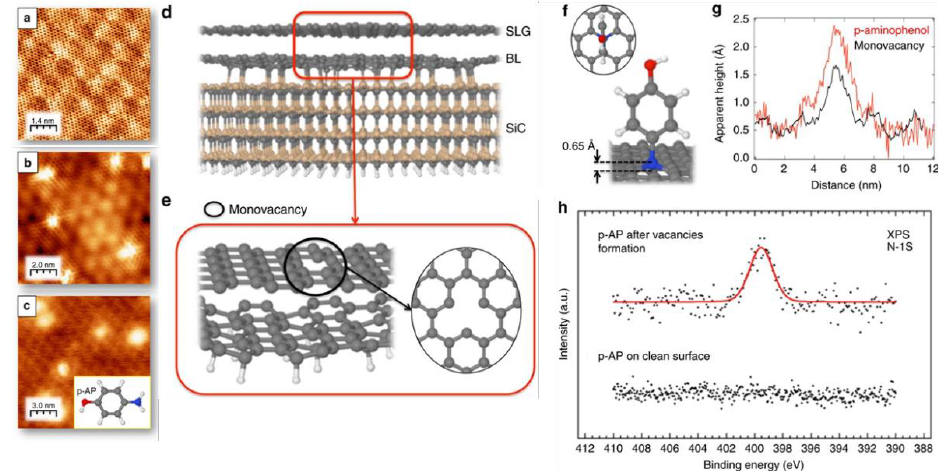
Figure 8. ( a ) Atomically resolved STM image of the (6 3 × 6 √3)R30° reconstruction of the single-layer epitaxial graphene grown on SiC(0001) (I = 0.36 nA, V = − 510.9 mV). ( b ) STM image of single-atom vacancies formed upon Ar + irradiation on the surface. (I = 2 nA, V = − 289mV) ( c ) STM image obtained after exposing defected layer to 4L of p-AP (I = 0.09 nA, V = − 1240 mV). ( d ) Pictorial representation of a fully relaxed model of 4H-SiC(0001) SLG/(6 √ 3 × 6 √ 3)R30° unit cell. ( e ) The optimised model ’ s top and side views for a single vacancy created within a SLG on a graphene buffer layer. In this model, the anchoring points between the graphene buffer layer and the SiC(0001) are saturated with H atoms with respect to the model shown in d. ( f ) Top and side views of the optimised geometry of a doubly dehydrogenated p-AP molecule with the nitrogen atom integrated into the SLG lattice within a single vacancy. Average perpendicular to the surface distance between the nitrogen atom and the SLG is also shown. ( g ) Typical STM Profiles on images b and c, along with a single-atom vacancy and a p-AP anchored molecule, respectively; ( h ) N 1s core-level spectra after dosing p-AP on an SLG surface without and with atomic vacancies. The N 1s binding energy corresponds to a C atom substitutional in the graphene network. Caption and figure were taken with permission and adapted from [23] — copyright by Springer Nature.